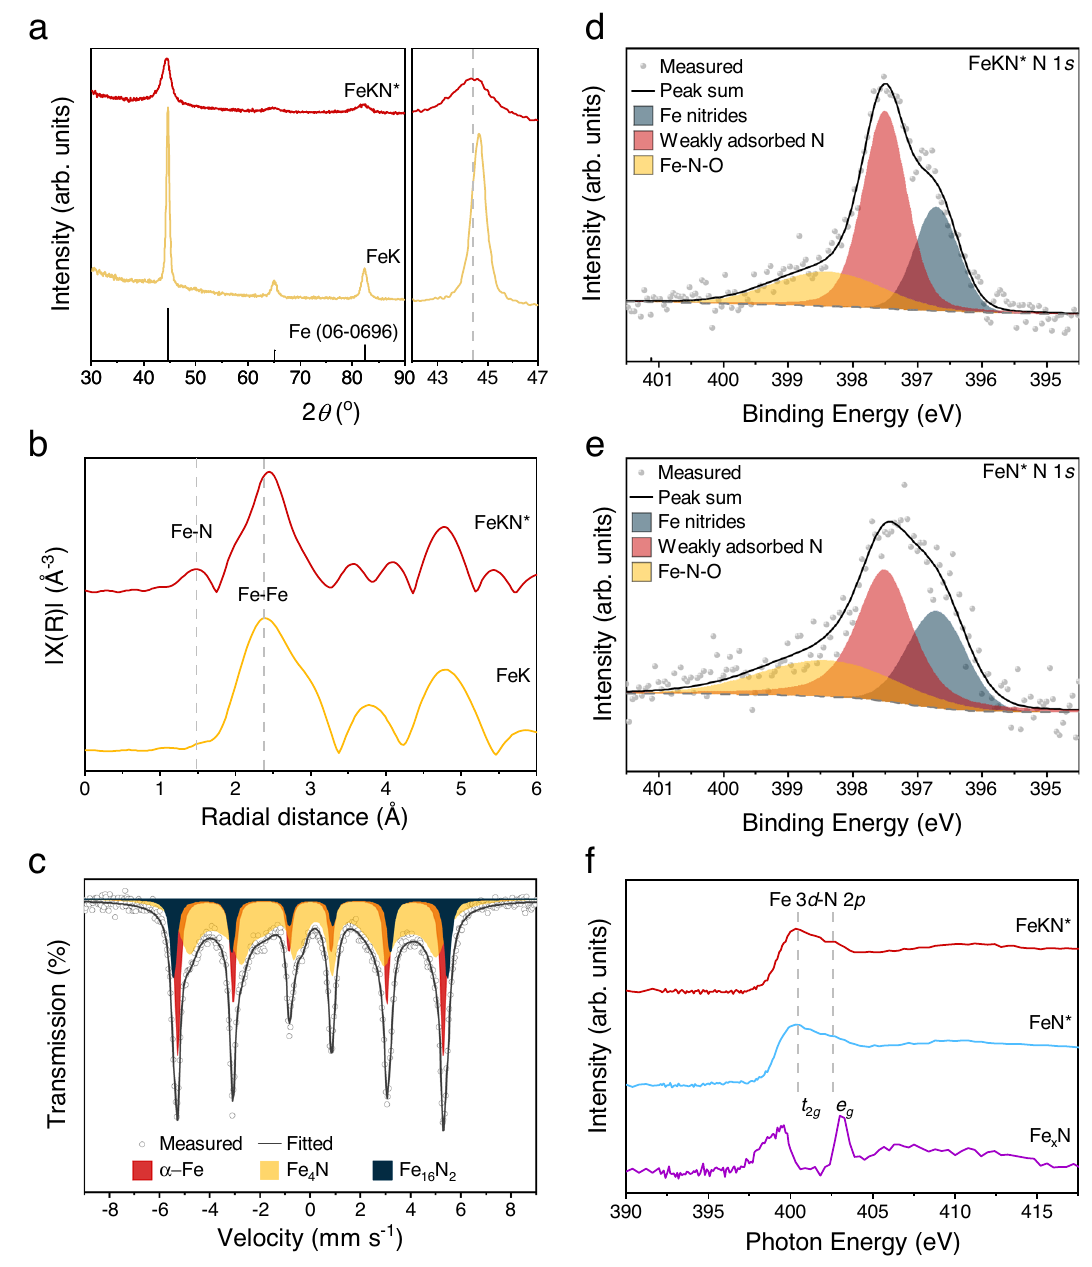
Fig. 5 | Characterizations of the catalysts. a XRD measurements of FeKN*, and regenerated FeK after hydrogenation. b Radial distribution function of FeKN* and regenerated FeK after hydrogenation. Radial distribution function was fi tted by